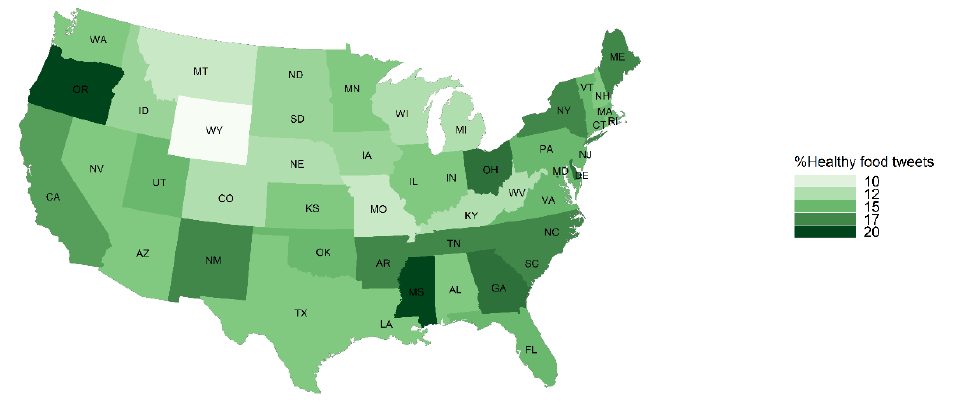
Figure 3. State level percent of food tweets with a healthy food mention in the contiguous United Figure 2. State level average caloric density per food tweet in the contiguous United States, Twitter States, Twitter 2015–2018.